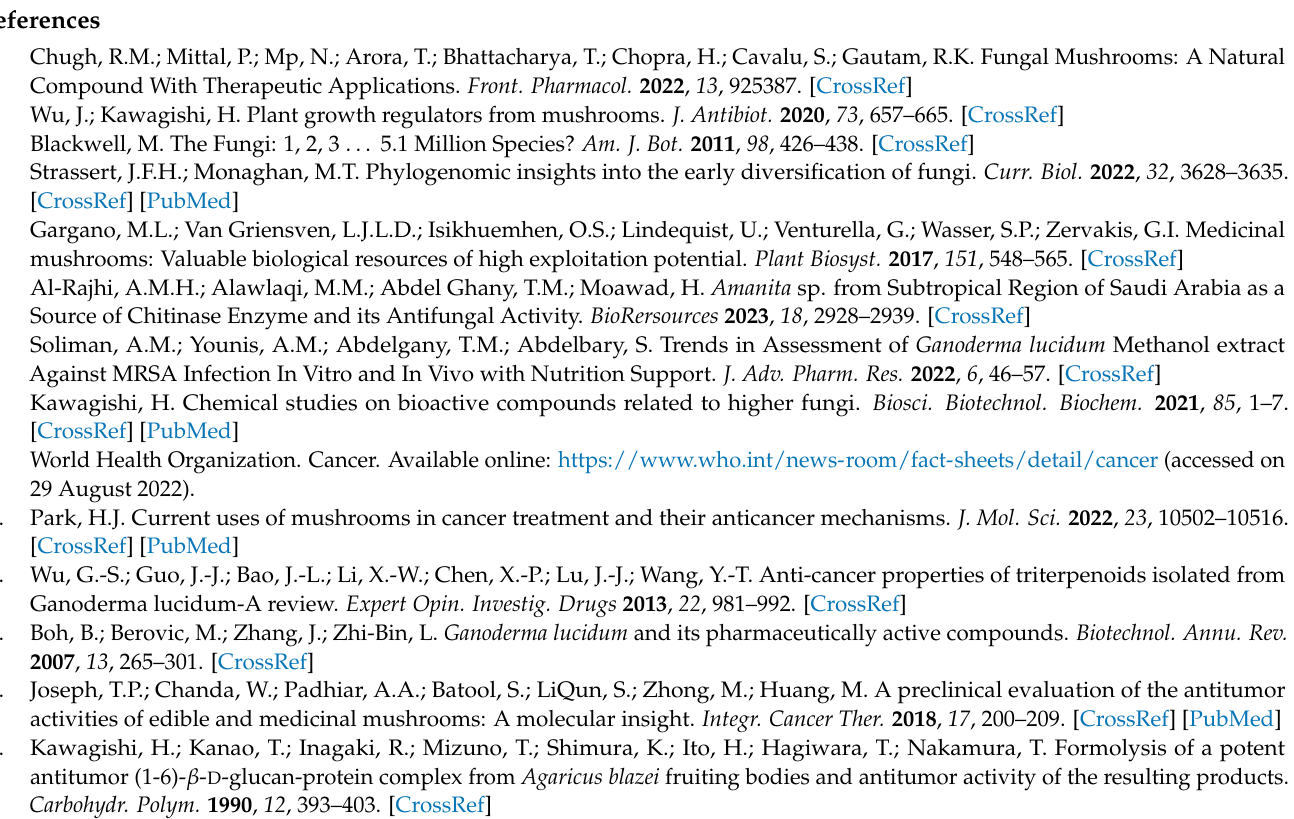
Figure S2: 13C NMR and DEPT spectra of 1 (CD3OD); Figure S3: HMQC spectrum of 1 (CD3OD); Figure S4: HMBC spectrum of 1 (CD3OD); Figure S5: COSY spectrum of 1 (CD3OD); Figure S6: 1H NMR spectrum of 2 (CD3OD); Figure S7: 13C NMR spectrum of 2 (CD3OD); Figure S8: 1H NMR spectrum of 3 (CD3OD); Figure S9: 13C NMR spectrum of 3 (CD3OD); Figure S10: 1H NMR spectrum of 4 (CD3OD); Figure S11: 13C NMR spectrum of 4 (CD3OD); Figure S12: 1H NMR spectrum of 5 (CD3OD); Figure S13: 13C NMR spectrum of 5 (CD3OD); Figure S14: 1H NMR spectrum of 6 (CD3OD); Figure S15: 13C NMR spectrum of 6